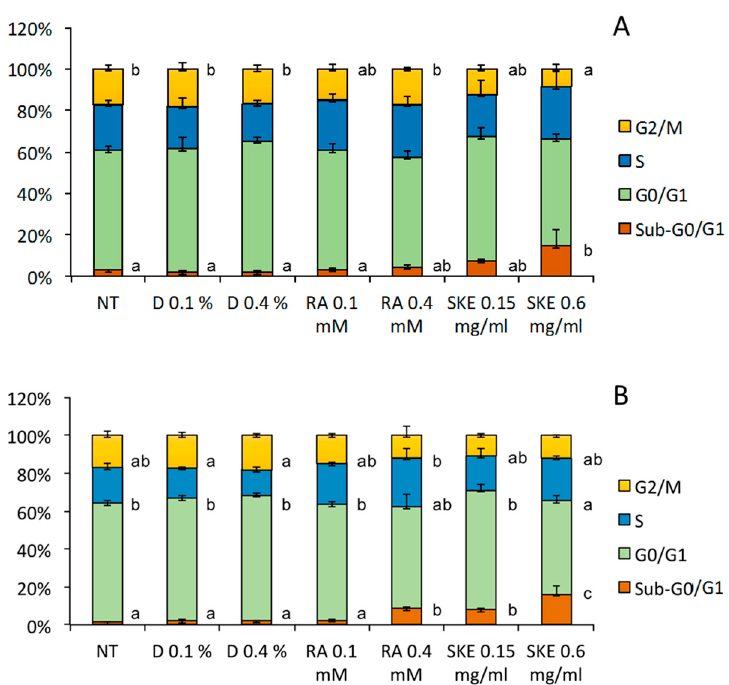
Figure 5. E ff ect of S. khuzistanica extracts on the percentage of MCF-7 cells in each phase of the cell cycle. Cell cycle distribution of MCF-7 cells treated for 24 h ( A ) and 48 h ( B ) with 0.15 mg · mL − 1 and 0.6 mg · mL − 1 S. khuzistanica extract (SKE), 0.1 mM and 0.4 mM rosmarinic acid (RA) or 0.1% and 0.4% DMSO (vehicle; D). Control cells were non-treated (NT). Each bar represents the mean ± SD of three replicates. For each phase of the cell cycle, di ff erent letters indicate significant di ff erences between treatments ( p <